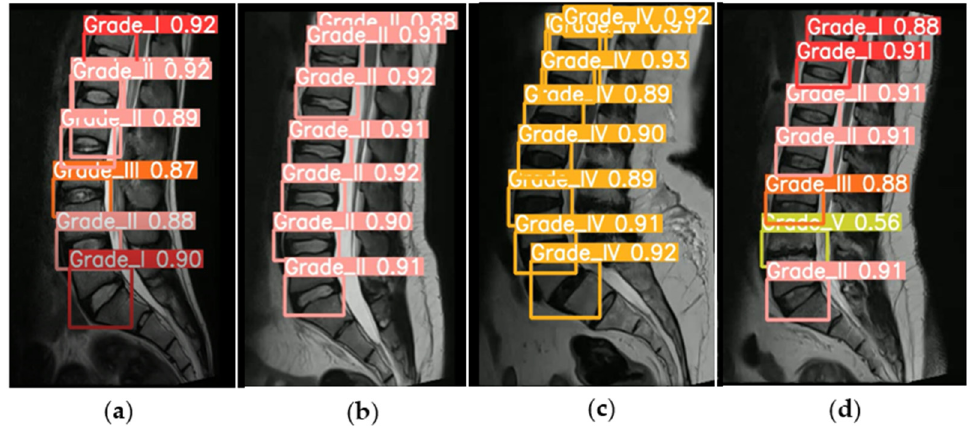
Figure 5. Results of automatic detection and grading of lumbar degenerative discs using convolu- tional neural network (CNN) with YOLOv5. Prediction based on the Pfirrmann grading system: patients with grade I–III ( a ), patients with grade II ( b ), patients with grade IV ( c ), and patients with grade I–V ( d ). The picture demonstrates the grading and the mean average precision.